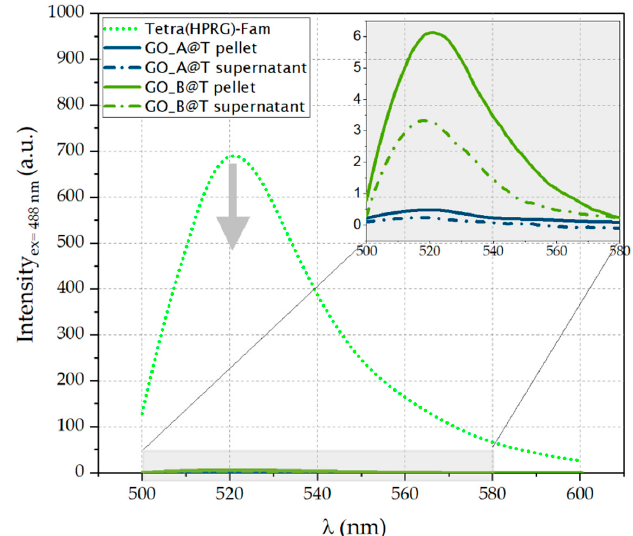
Figure 3. Fluorescence spectra ( λ excitation = 488 nm) in PBS (pH = 7.4) of free Tetra(HPRG)-Fam peptide (dot green line) and GO@T hybrids (GO_A@T: dark green line; GO_A@T: light green line). In the inset the magnified region for the pellets (solid lines) and supernatants (dashed-dot lines).